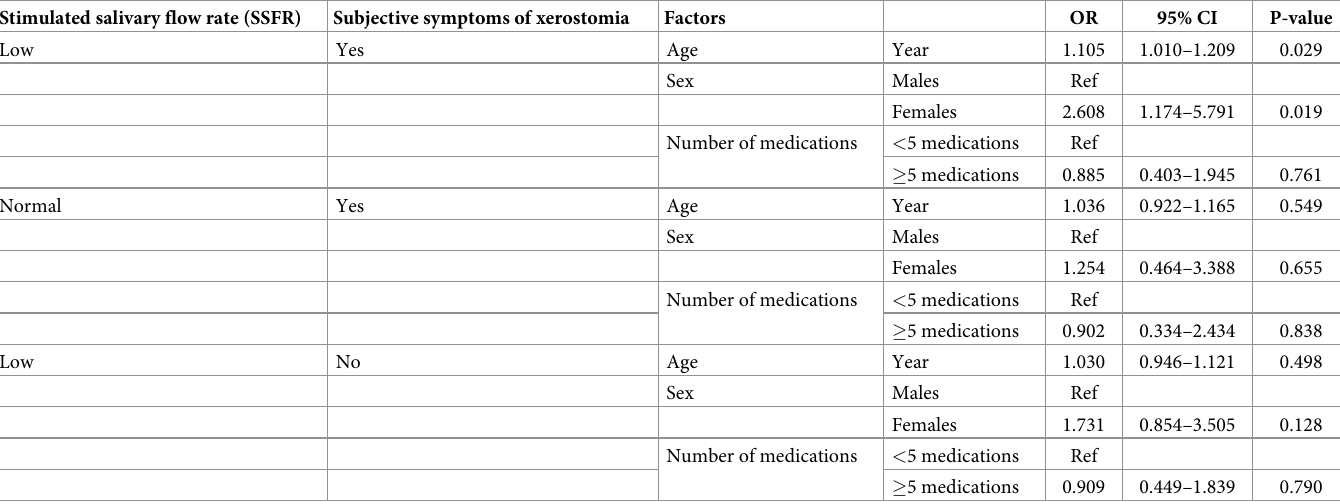
Reference category for dependent variable: Group with normal stimulated salivary flow rate (SSFR) and without subjective symptoms of